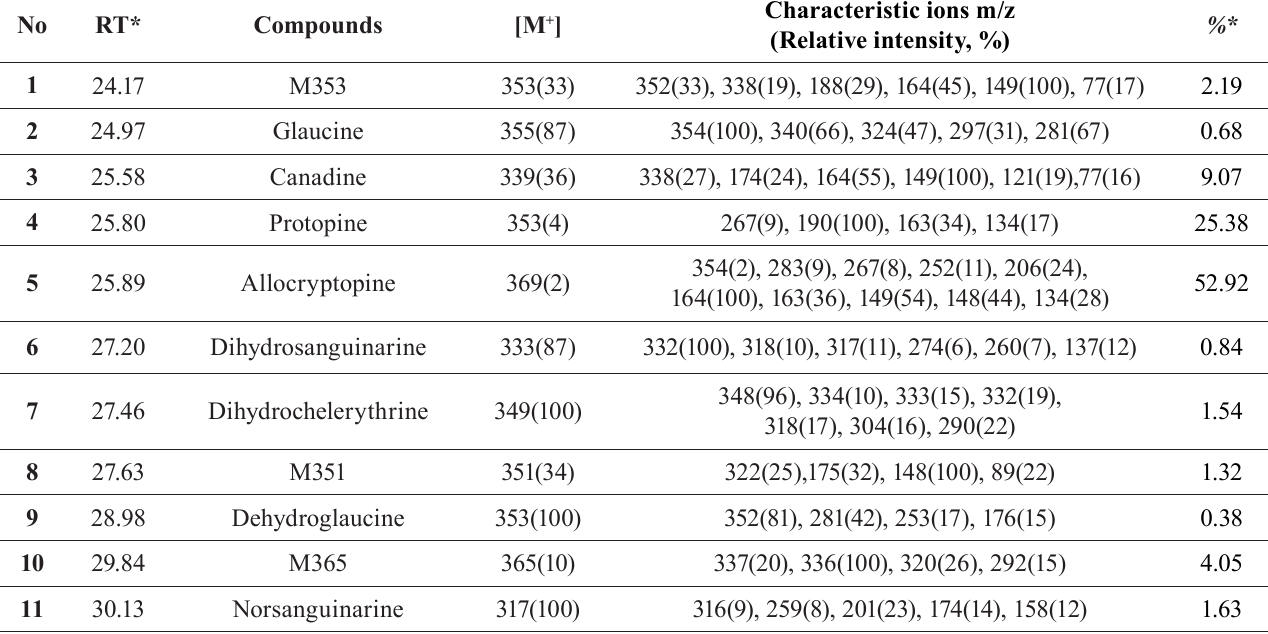
TABLE I - C hemical constituents of G. corniculatum subsp. refractum alkaloidal extract analyzed by GC-MS